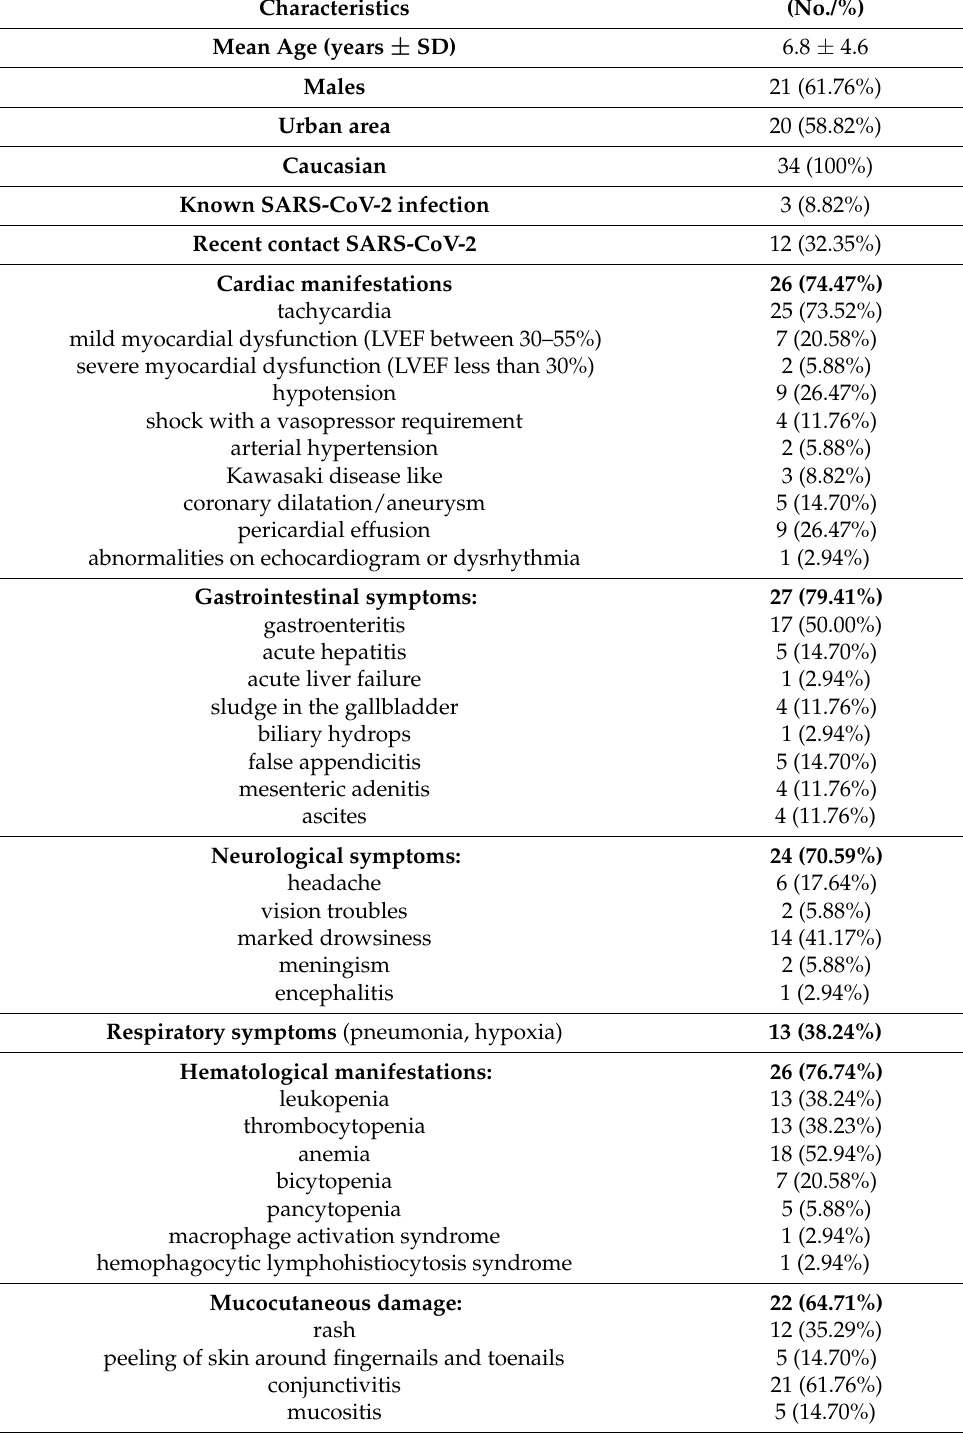
Table 1. Characteristics at the first presentation of children with